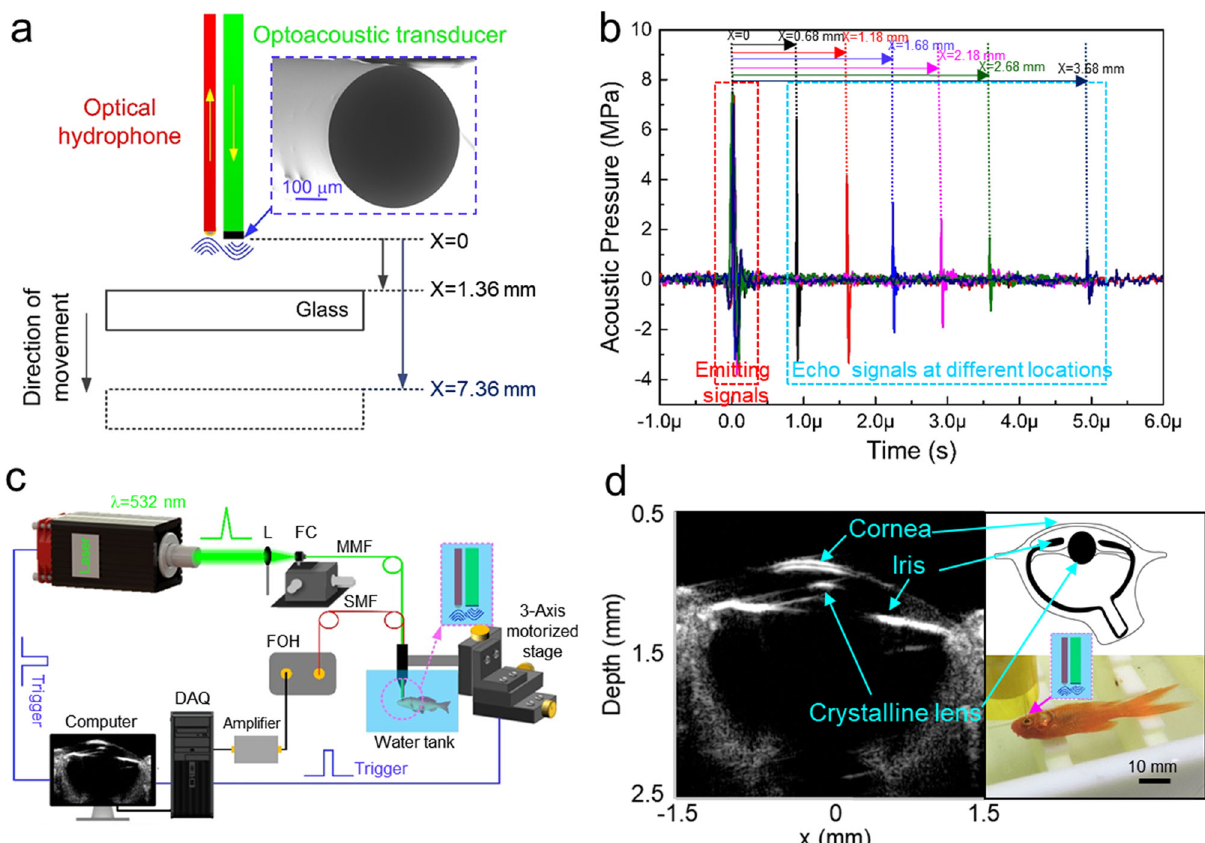
Fig. 4 The optical fi ber-based optoacoustic transducer. a Schematic diagram of echo signal detection. b Measured echo signals re fl ected by glass at different locations. The gray, red, blue, pink, green, and dark blue curves represent the echo signals re fl ected by the glass at x = 0.68, 1.18, 1.68, 2.18, 2.68, and 3.68 mm, respectively. c The all-optical ultrasound imaging system. L lens, FC fi ber coupler, MMF multimode fi ber, SMF single-mode fi ber, FOH fi ber- optic hydrophone, DAQ data acquisition card. d Laser-generated ultrasound for imaging of fi